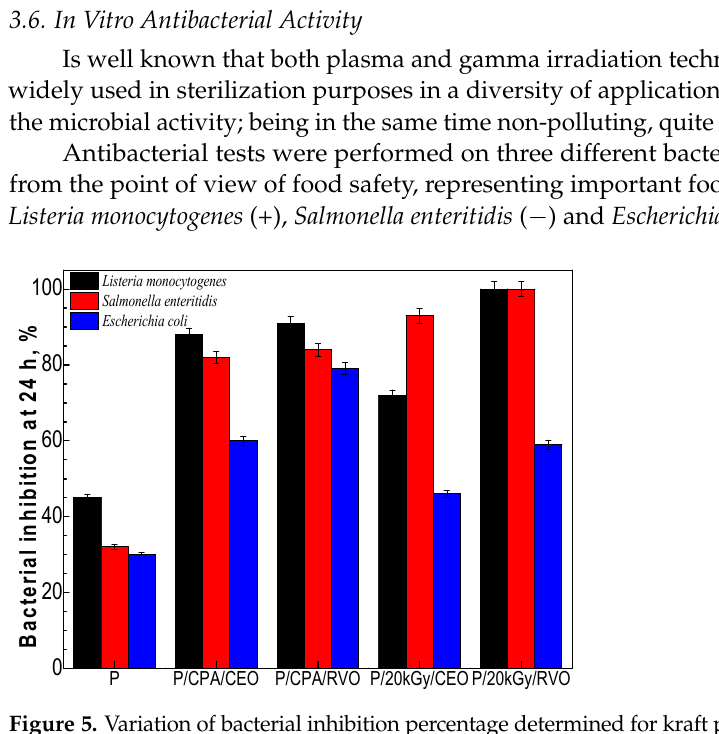
Figure 5. Variation of bacterial inhibition percentage determined for kraft paper modified by plant oils.